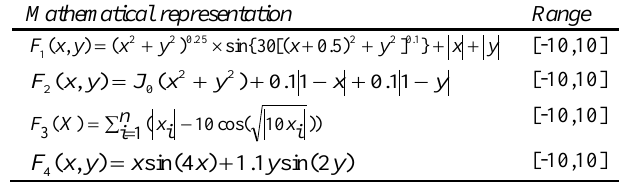
Table 1.Benchmark functions Algorithmic parameters for all algorithms are illustrated in Table 2.